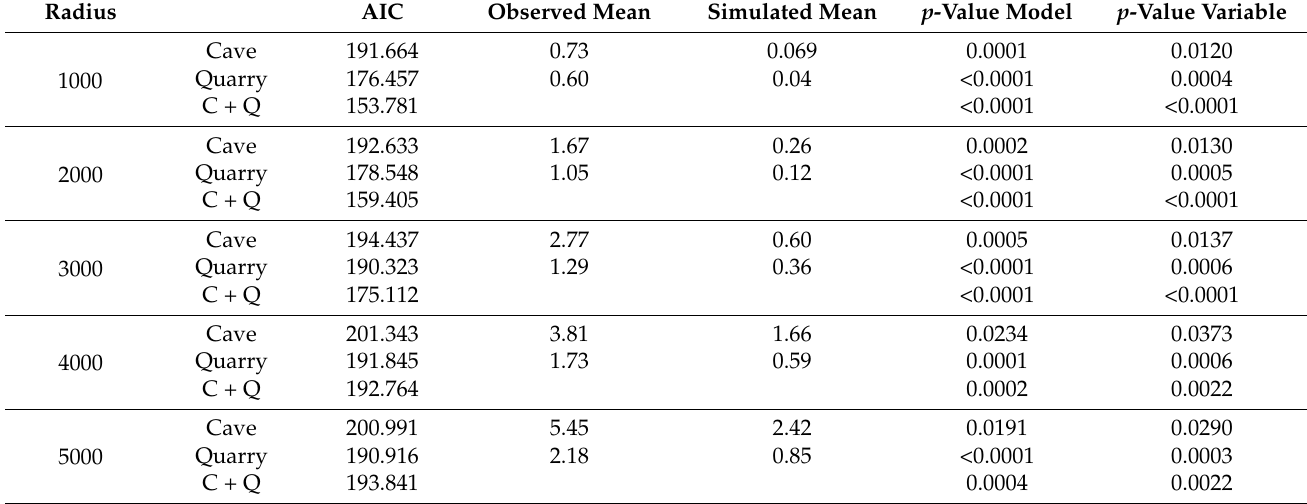
Figure 3. Comparison between the percentage of quarries (black, n = 30) and caves (white, n = 63) occupied by eagle owls ( Bubo bubo ) during 2006–2010. The preference for quarries is evident from the difference in nest placement between the two potential habitats. Table 2. The probability of an eagle owl ( Bubo bubo ) nest in area (1–5 km radius) decreases with spatial scale, as expressed by lower significance values. Combined = number of caves and quarries. AIC denotes the Akaike Information